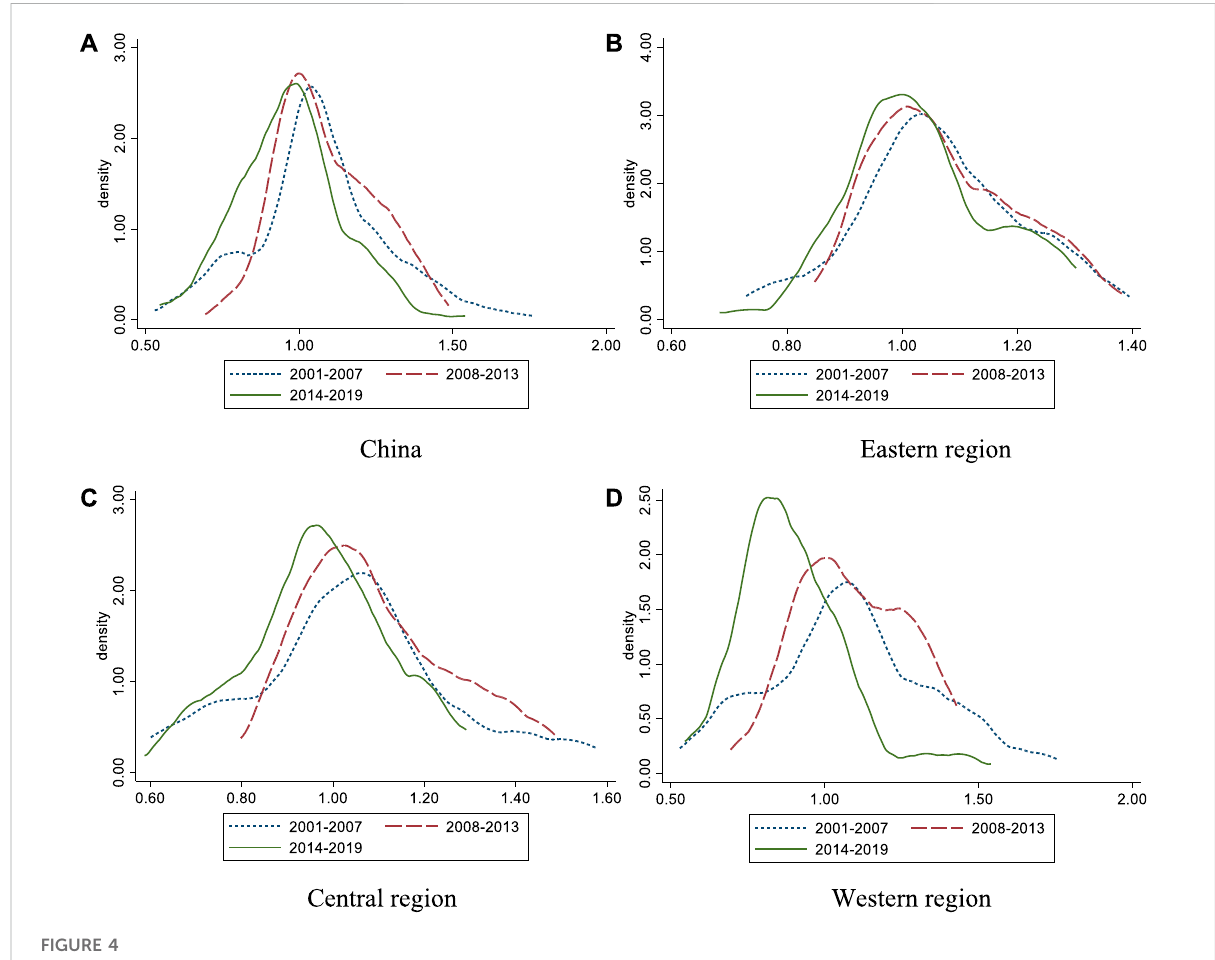
FIGURE 4 Dynamic evolution of TC . (A) China, (B) Eastern region, (C) Central region, (D) Western